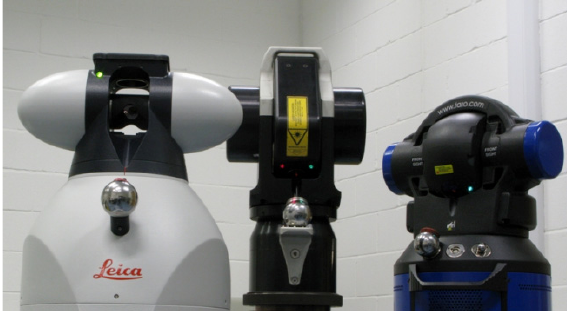
Fig. 1. Examples of laser trackers.